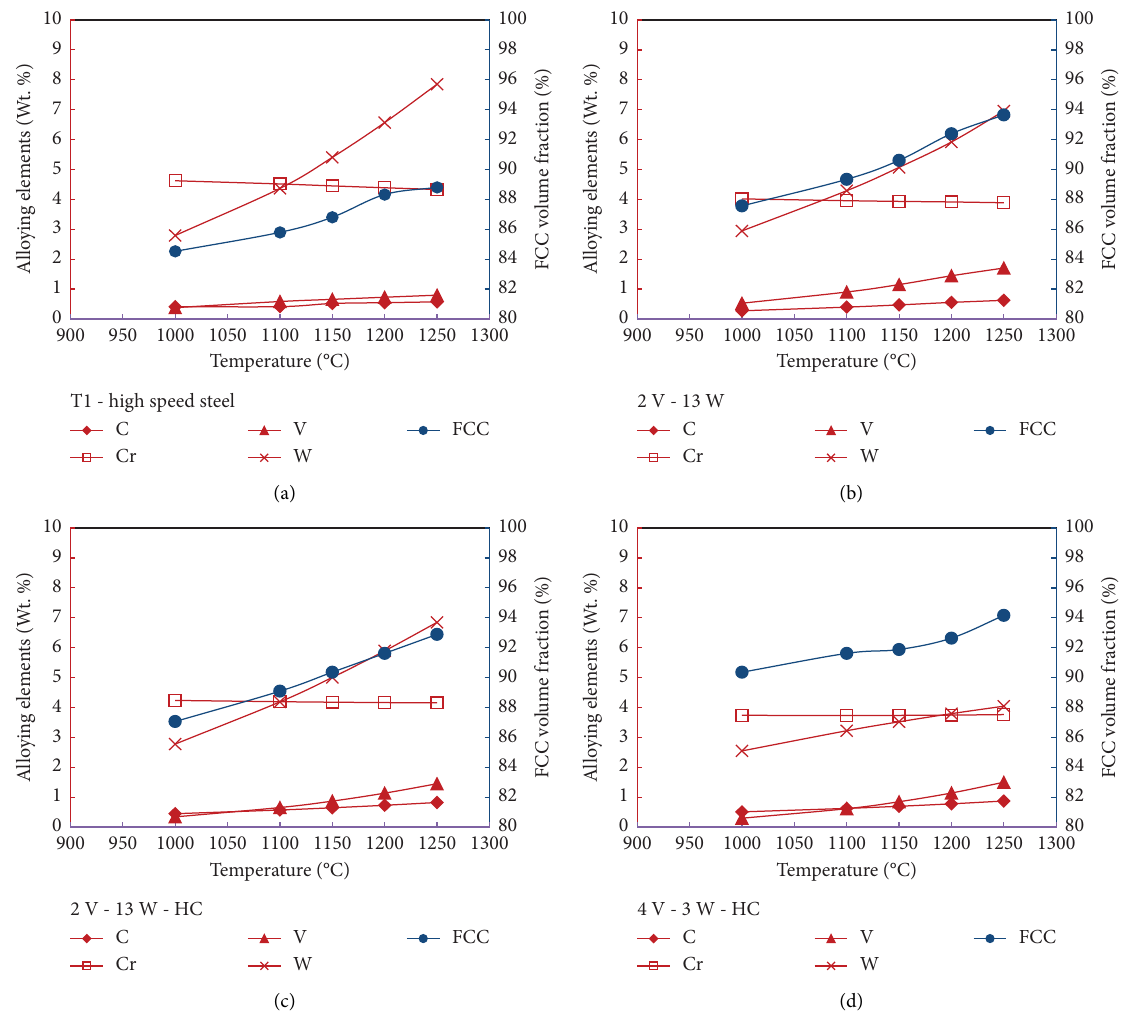
Figure 17: Chemical composition and the volume fraction of the austenitic (FCC) matrix presented in investigating steel at diferent austenitization temperatures. (a) T1 high-speed steel, (b) 2V-13W, (c) 2V-8W-HC, and (d) 4V-3W-HC.